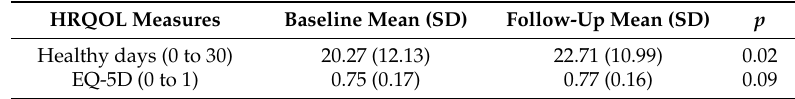
Table 2. Descriptive Statistics: health-related quality of life (HRQOL) measures.